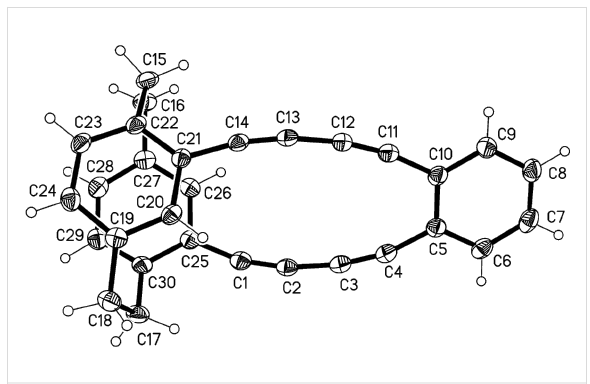
Figure 5: The molecule of compound 22 in the crystal; ellipsoids represent 50% probability